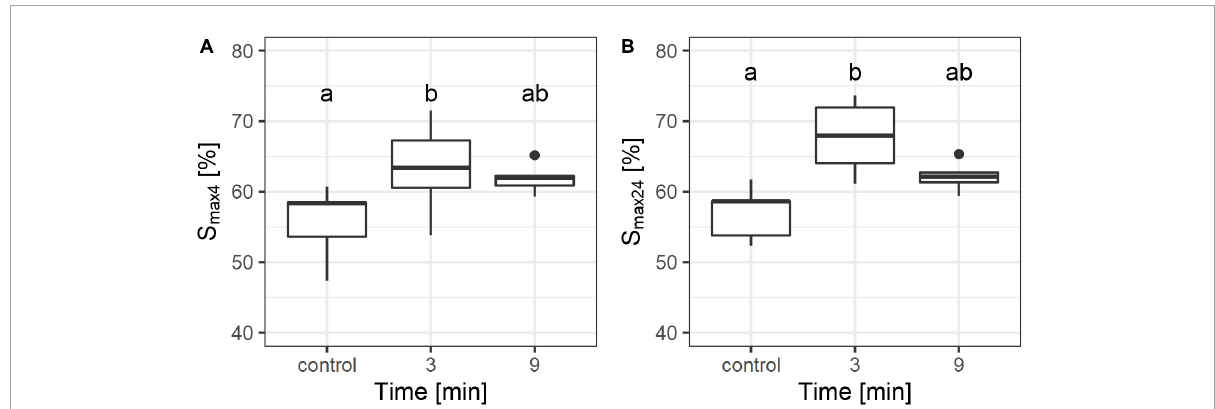
FIGURE3 Maximum water storage capacity after 4 h (A) and after 24 h (B) of soil subjected to different combustion times. Different letters on this figures indicate significant differences between the groups (according to Duncan test, p < 0.05). The line within the box represents median; the box represents interquartile range; the whiskers represent the largest and the smallest value within 1.5 times interquartile range above 75th and below 25th percentile, respectively; the points represent outliers.